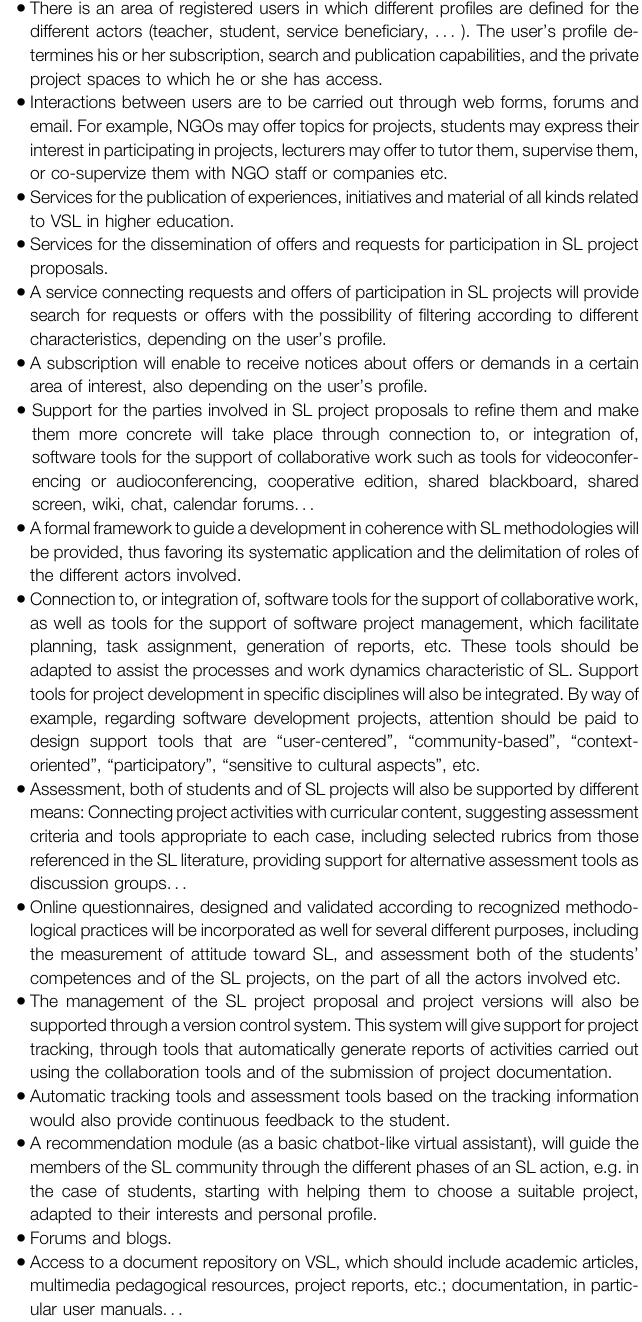
TABLE 1 | Virtu@l-ApS Functionality Basic